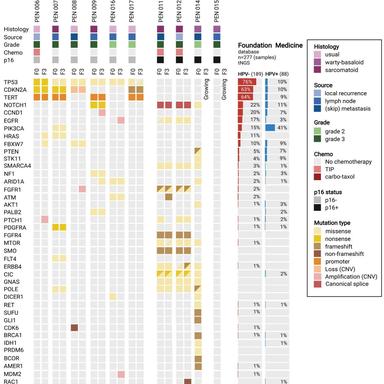
Left panel: oncoplot showing altered genes, assessed via targeted next-generation sequencing (tNGS) using our panel of 96 cancer genes, and their specific mutation type per patient (F0) and in comparison to the corresponding patient-derived xenograft model (F3). The corresponding source of tumor tissue, histology, grade, p16 status, and previous therapy are also indicated. Right panel: horizontal bar plots showing the percentages of the aforementioned mutated genes detected in the Foundation Medicine datab